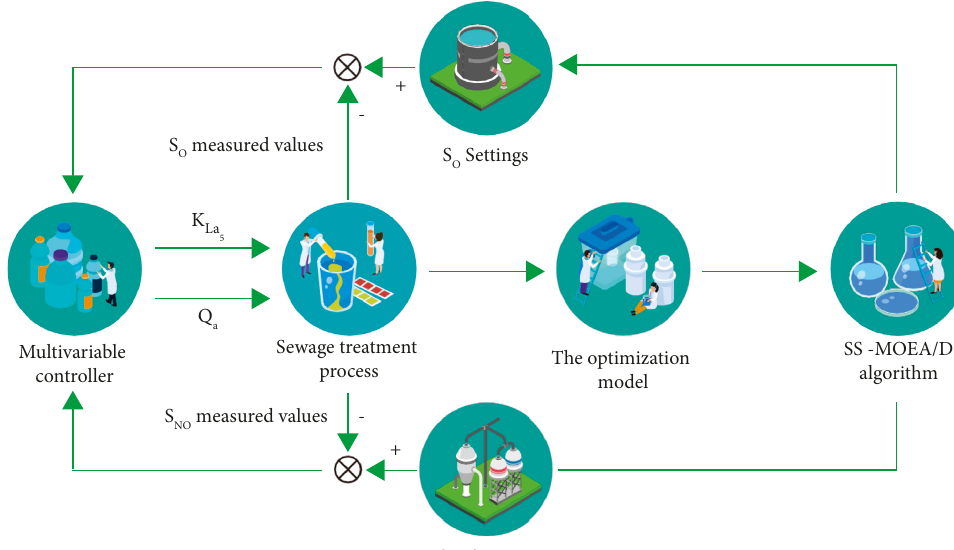
Figure 1: Optimization control